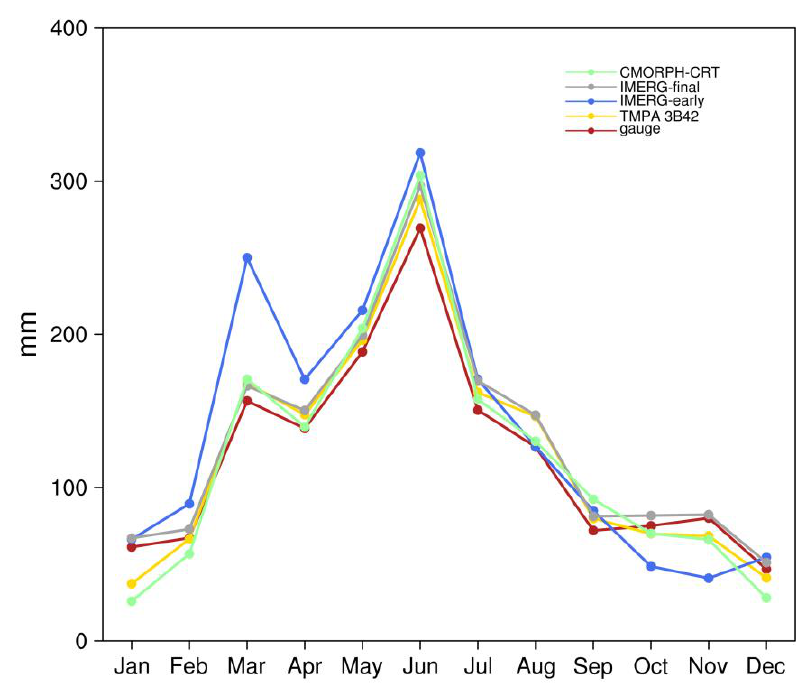
Figure 4. Spatial-averaged monthly total precipitation in Hunan.